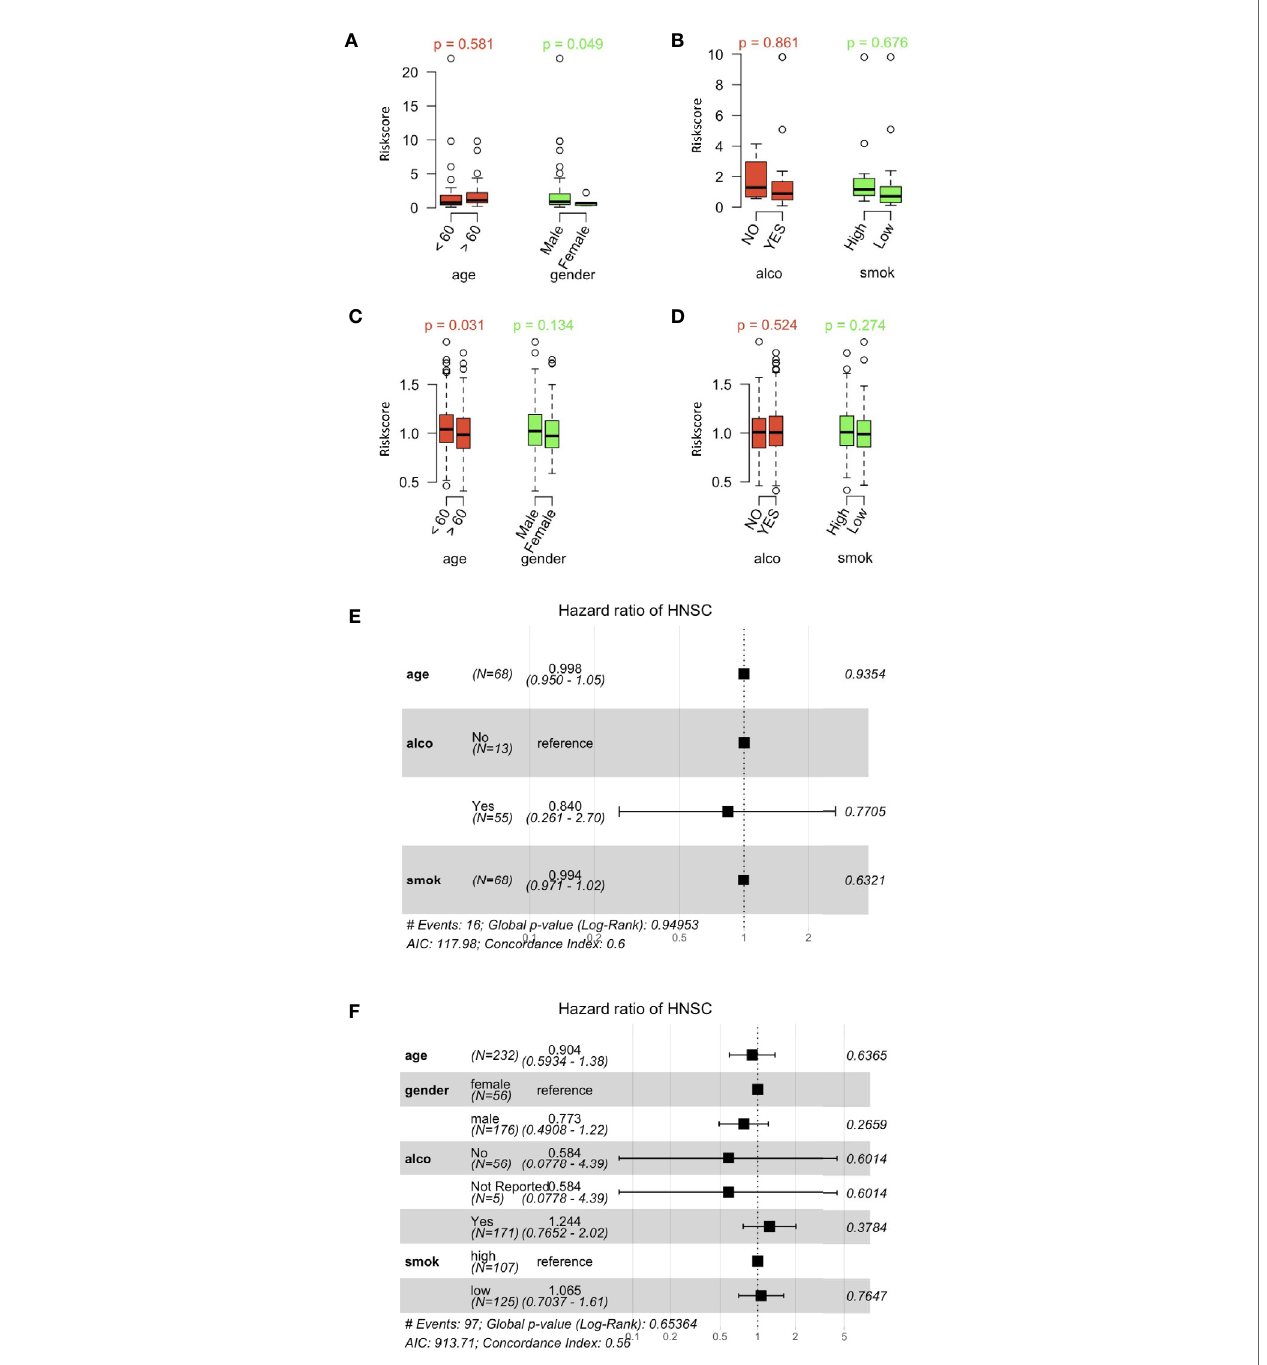
FIGURE 6 | Correlation between risk scores and clinically related characteristics of HNSCC patients. (A) Distribution of risk scores obtained when patients ’ data obtained from the HPV+ HNSCC TCGA dataset were separated by age and sex. (B) Risk score distributions for alcohol and smoking in the HPV+ HNSCC TCGA dataset. (C) Distribution of risk scores obtained when patients ’ data obtained from the HPV- HNSCC TCGA dataset were separated by age and sex. (D) Risk score distributions for alcohol and smoking in the HPV- HNSCC TCGA dataset. (E) Multi-variate Cox regression forest plots of the risk scores and clinically related characteristics in the HPV+ HNSCC TCGA dataset. (F) Multi-variate Cox regression forest plots of risk scores and clinically related characteristics in the HPV- HNSCC TCGA dataset. Alco and Smok refer to alcohol consumer and